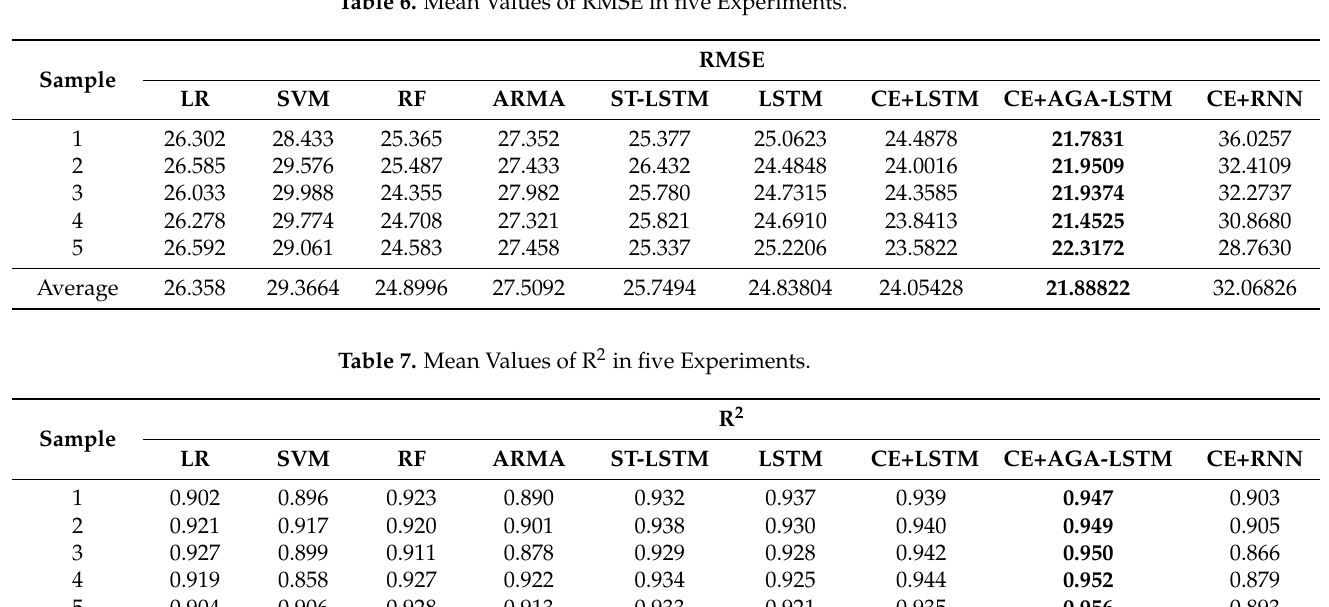
Table 6. Mean Values of RMSE in five Experiments.